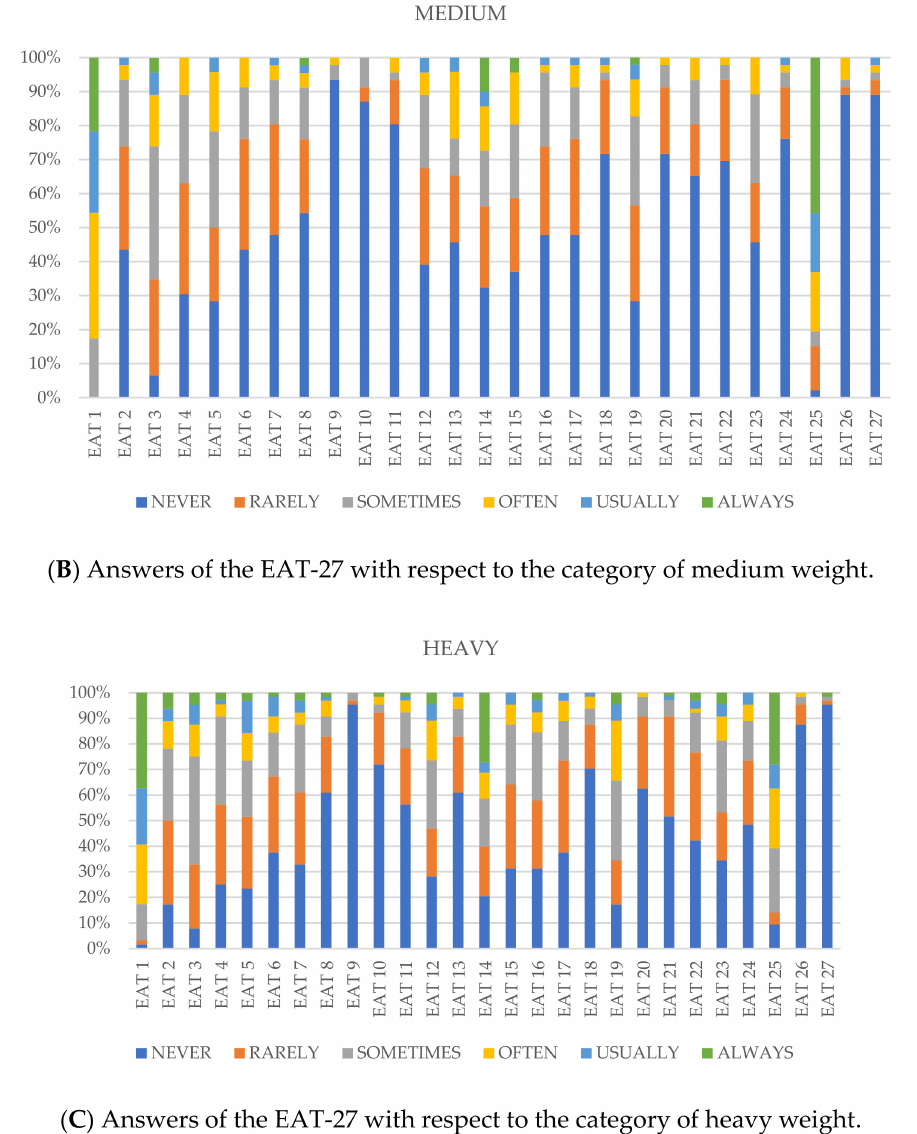
Figure 1. Answers of EAT-27 with respect to different weight categories (light, medium and